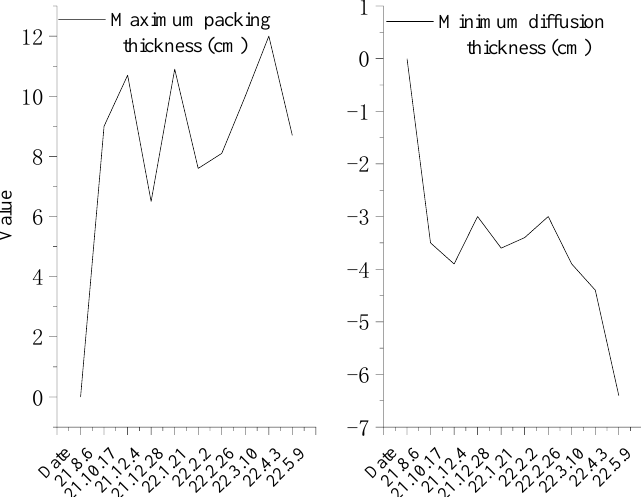
Figure 9. Cumulative maximum and minimum changes in ground height in the Mud receiving area observed during D-InSAR observations.